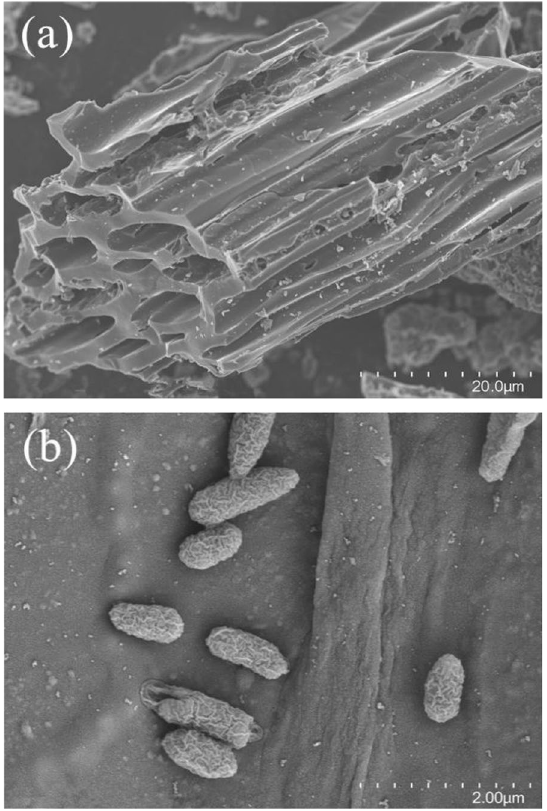
Fig. 1 SEM images of biochar ( a ) and biochar carried microbial agent